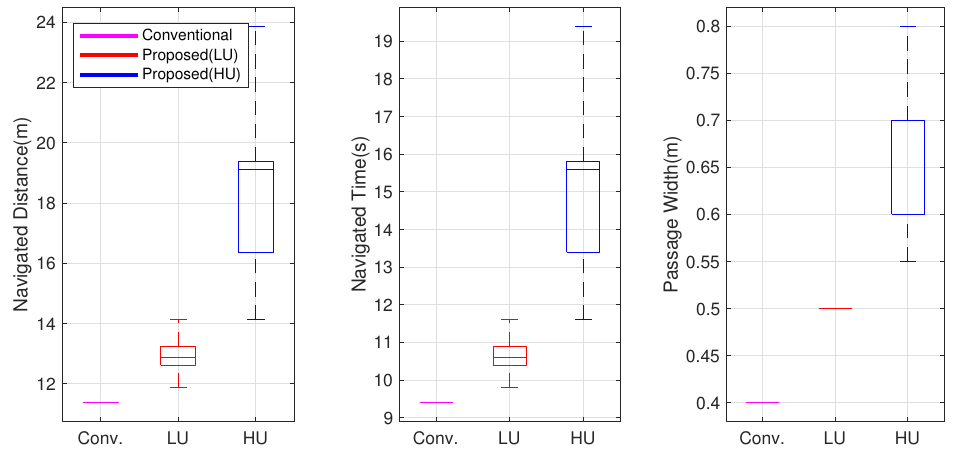
Figure 12. Comparisons of navigated distance, navigated time, and passage width.